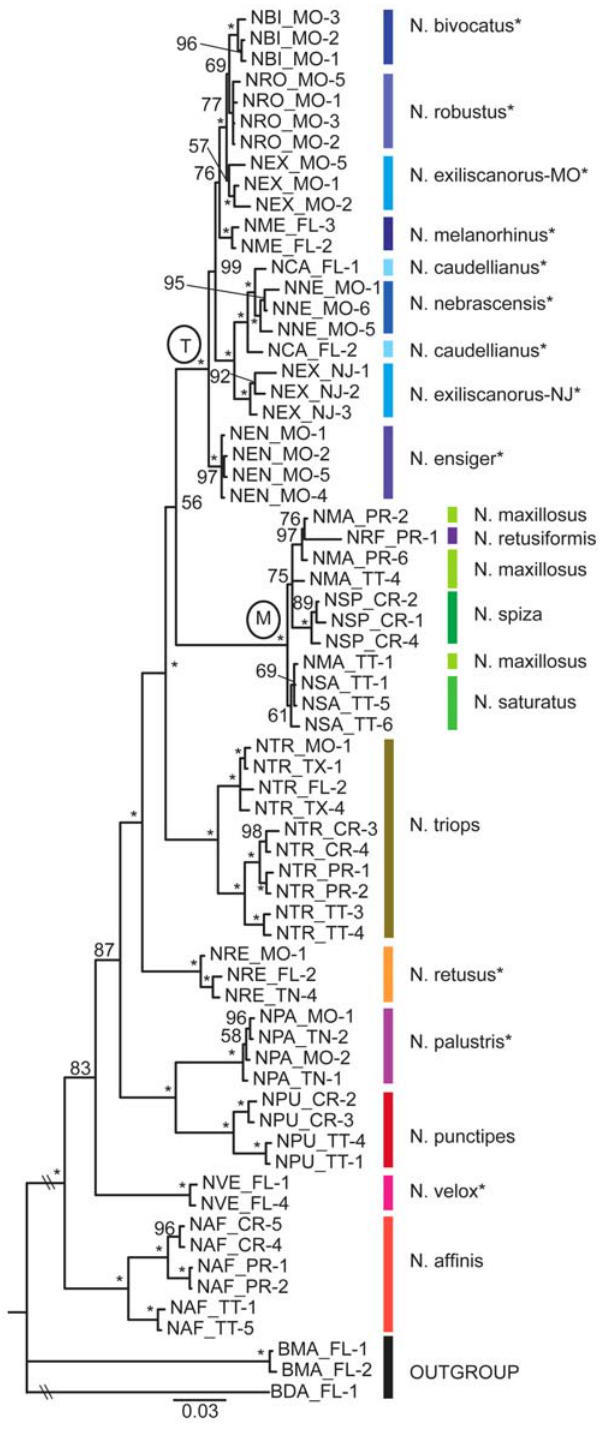
Figure 4. Phylogeny of Neoconocephalus based on the com- bined analysis of the nuclear and mitochondrial genes. Bayesian phylogeny of Neoconocephalus using the combined H3, ITS and COI data sets. Nodal support values are given as posterior probabilities in percent; asterisk indicate 100%. The temperate clade and the N. maxillosus clade are indicated by labels ‘T’ and ‘M’, respectively. Branch lengths drawn to scale. The taxa included in this tree are listed in Table S1. Asterisks at the species names indicates temperate life history. Species are indicated by colored lines.